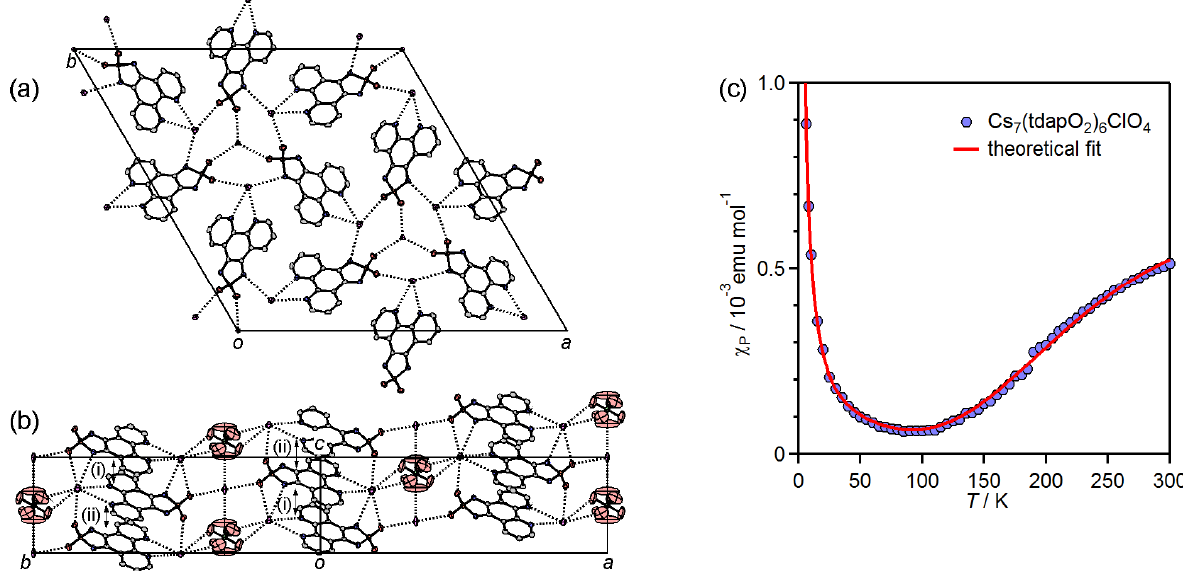
21. Crystal structure ( a , b ) and temperature dependence of χ Cs •(tdapO ) •ClO . Adapted with permission from [48]. Copyright 2013 7 2 6 4